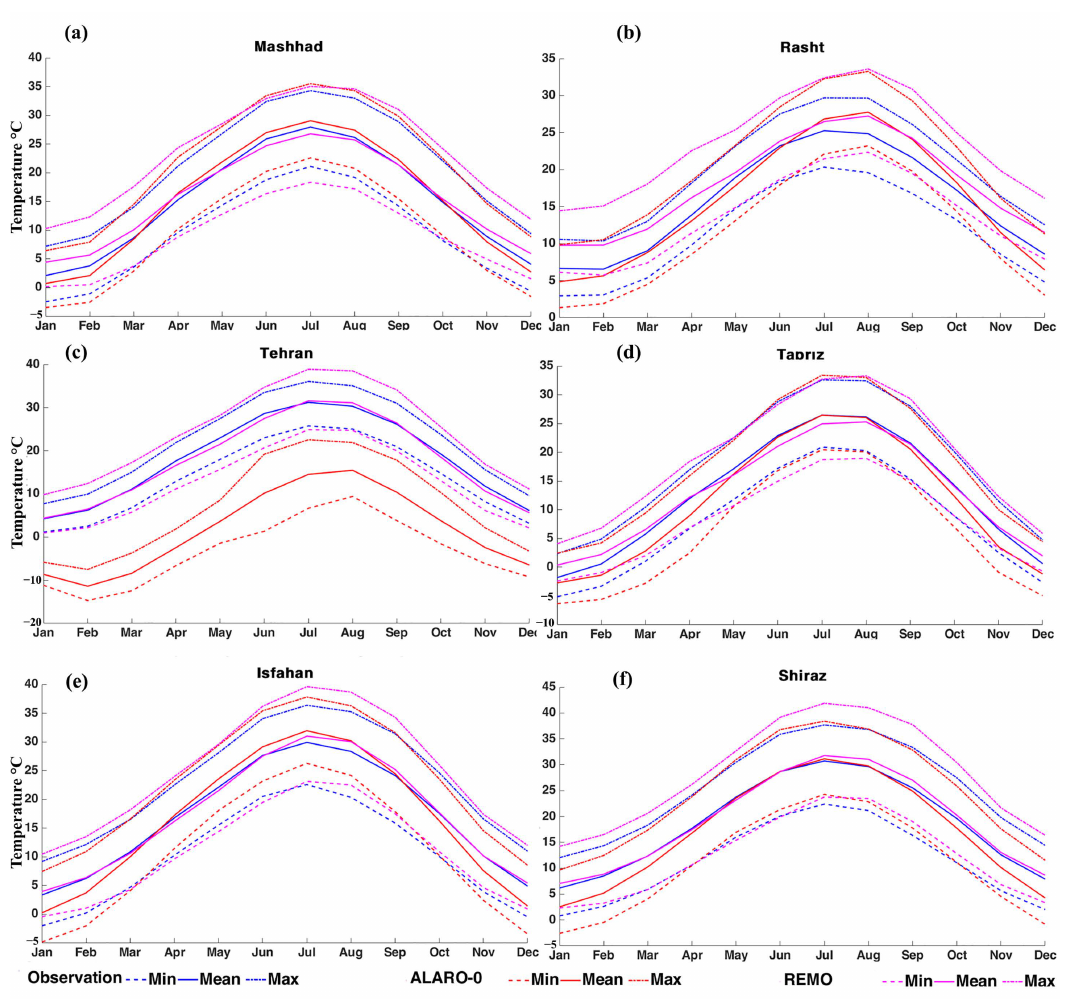
Figure 6. Annual cycles for minimum, mean and maximum temperature comparing models with observation for Mash- had ( a ), Rasht ( b ), Tehran ( c ), Tabriz ( d ), Isfahan ( e ) and Shiraz ( f ) during